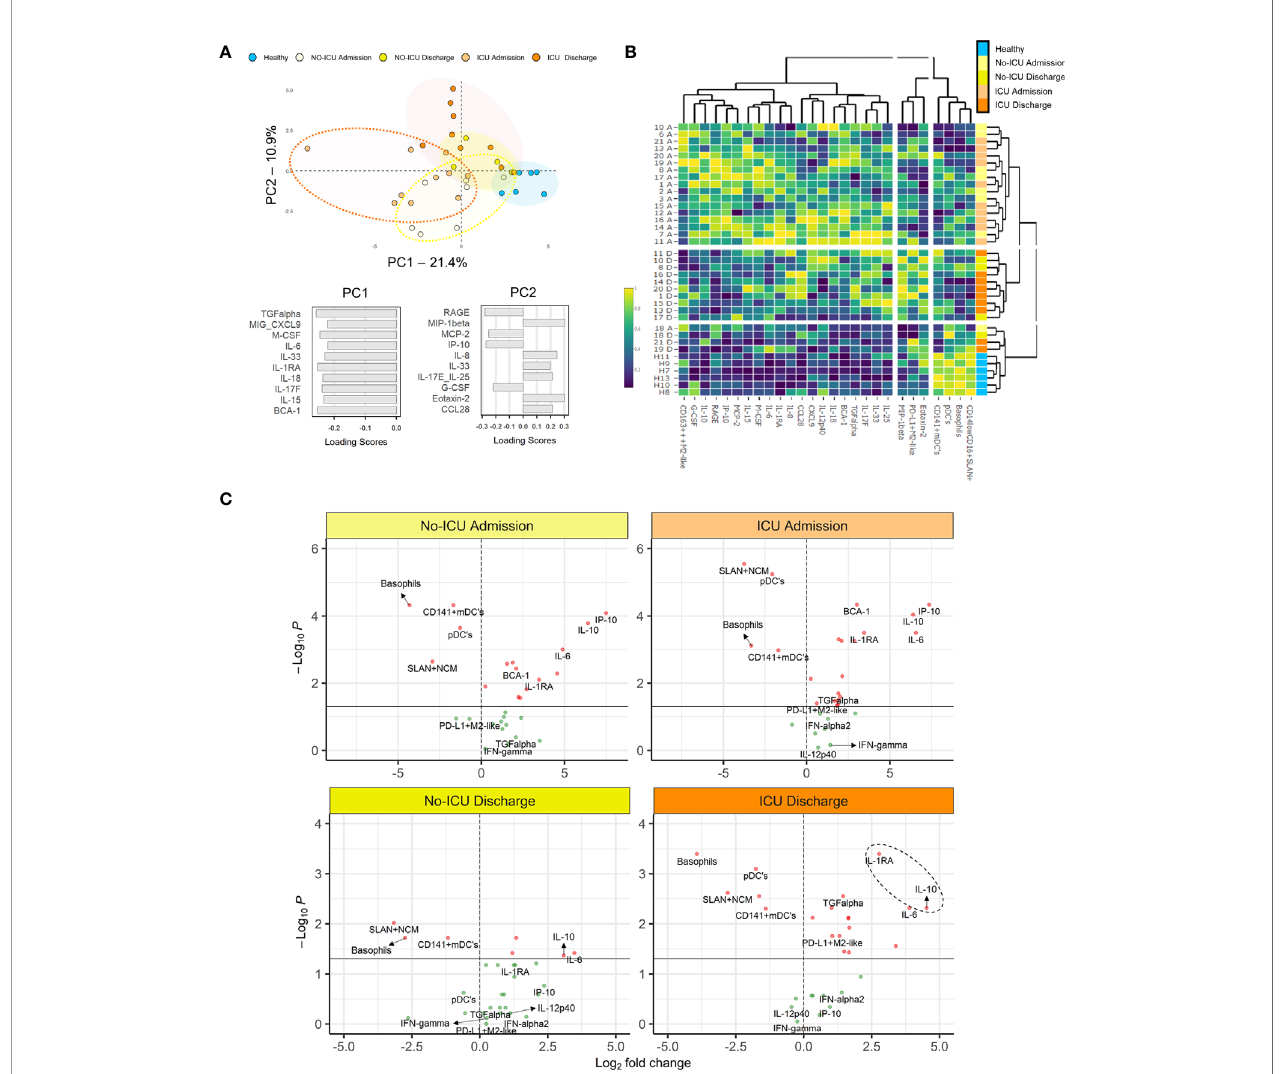
FIGURE 6 | Myeloid cell populations and in fl ammatory/immunoregulatory serum markers segregate COVID-19 stages. (A) Principal component analysis (PCA) of the 35 serum analytes showed to have signi fi cant different levels as compared to healthy or between the time-points analyzed; loading scores of principal component (PC)1 and PC2 showing the top 10 highest absolute values. (B) Heatmap performed using the top 10 parameters in the PC1 and PC2 of the PCA analysis showed in (A) and the frequencies of the X-shift clusters found to be signi fi cantly altered in COVID-19 patients; dendrograms illustrate the hierarchical clustering; a color code was added to identify individual groups. (C) Volcano plots comparing the variables used in the heatmap showed in (B) in patient groups and healthy controls; p < 0.05 were considered signi fi